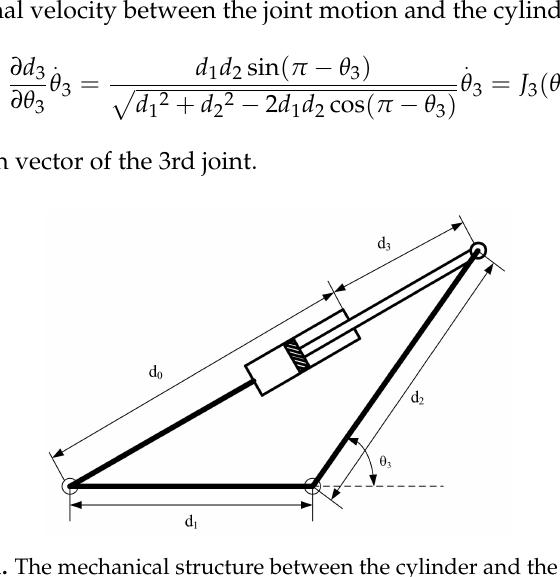
Figure A1. The mechanical structure between the cylinder and the joint